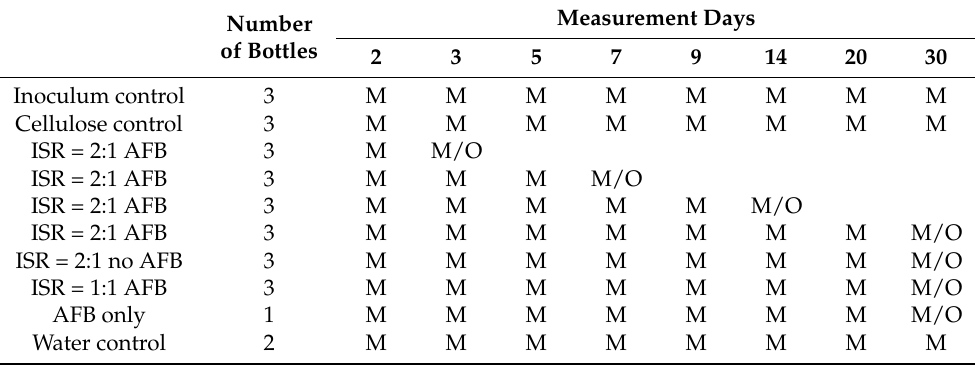
Table 1. Batch assay experimental bottles with measurement days (M) and day of opening (O).